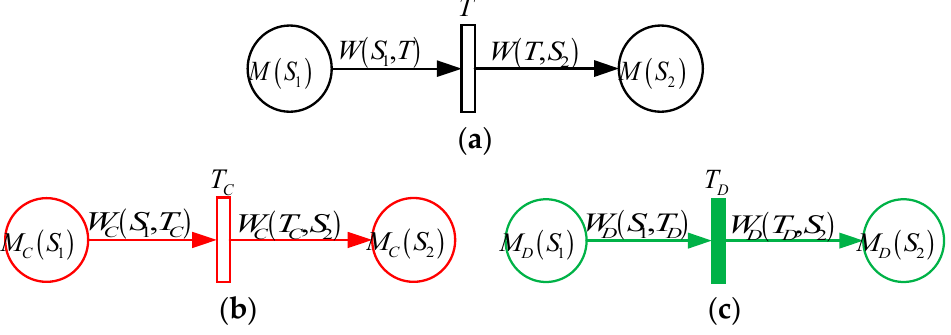
Figure 2. A simple HCCPNS model. ( a ) Folded model; ( b ) unfolded model: continuous part; ( c ) unfolded model: discrete part.